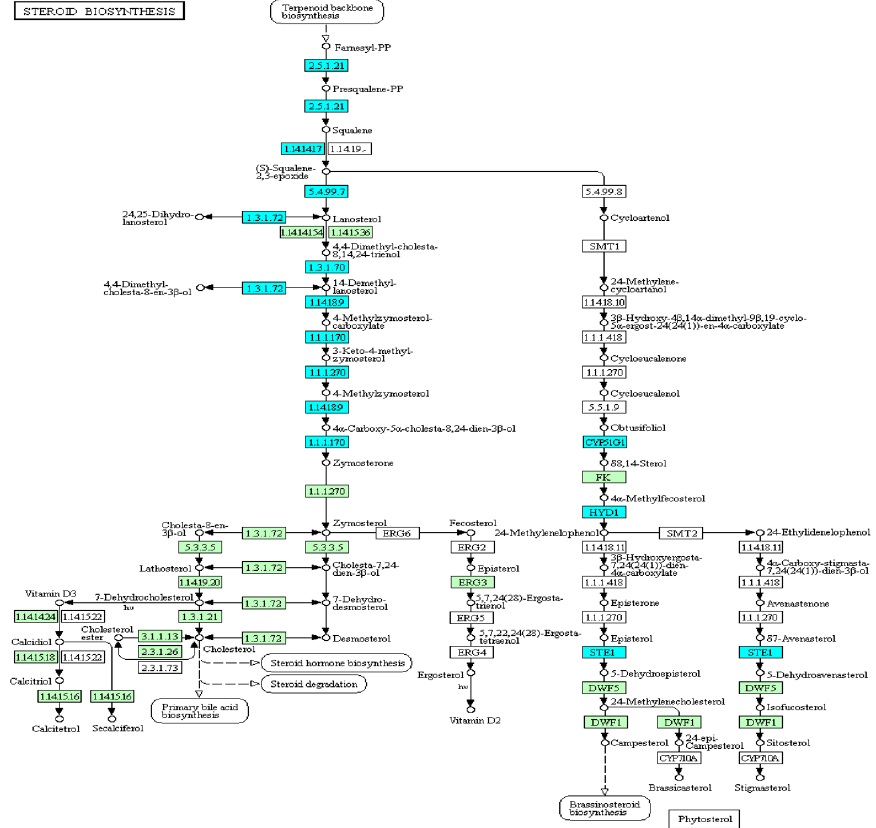
Figure 9. Expression patterns of the steroid biosynthesis pathway in common carp head kidney: All target genes are colored in blue.